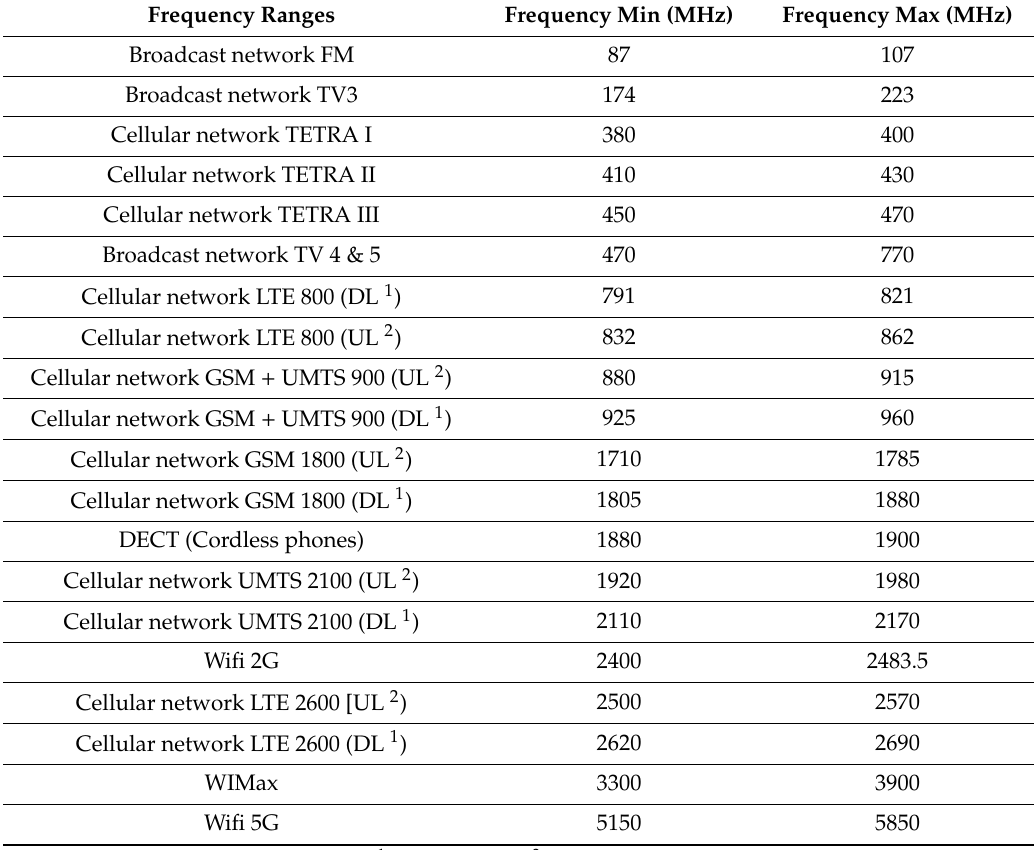
Table 1. Frequency ranges explored by the SATIMO EME-SPY 200